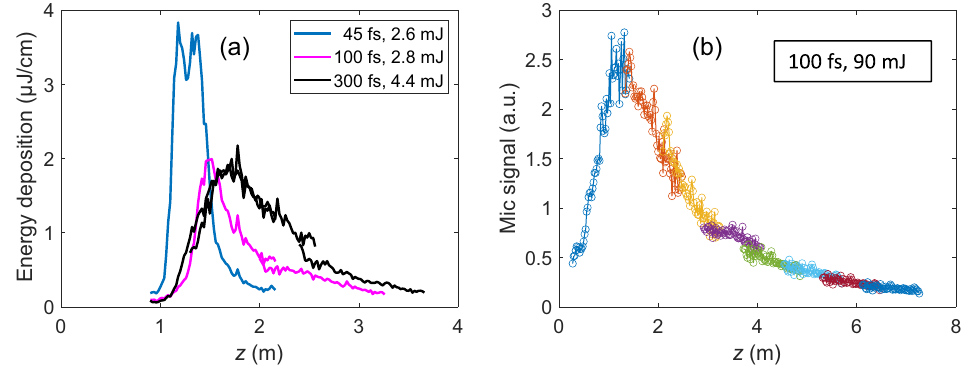
FIG. 3. (a) Single-filament energy absorbed per unit length vs propagation distance measured by microphone array for laser-pulse widths 45, 100, and 300 fs. Pulse energies are chosen to keep peak power constant at ∼ 6 P 126-cm longitudinal sections averaged over 100 shots. The array was 3 mm from the beam axis. (b) Acoustic signal from filamentation of 100-fs, 90-mJ LG 01 pulse. The microphone array was 5 mm from the beam axis. Concatenated and overlapped 126-cm longitudinal sections averaged over 100 shots are plotted in different